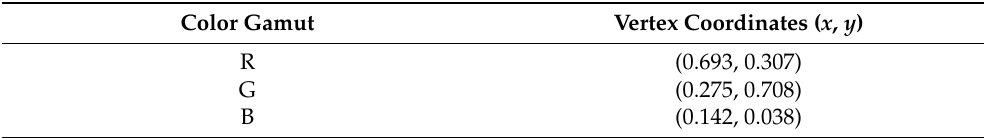
Table 4 lists the color gamut coordinate parameters of the 17 in extra-thin, large-area, high-luminance surface light source module. The coordinate position ( x , y ) in the CIE 1931 color gamut coordinate was determined according to the emission spectrum of the module. Table 4. Color gamut coordinate parameters of the extra-thin, large-area, high-luminance surface light source